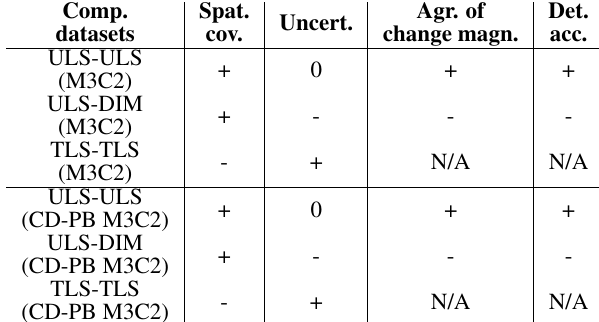
Table 3. Performance of biennial change analysis at a rock glacier with M3C2 and CD-PB M3C2 using point cloud pairs originating from UAV-borne laser scanning (ULS), UAV-borne photogrammetry using dense image matching (DIM), and terrestrial laser scanning (TLS) as input. Performance (+: best; 0: medium; -: worst of the two/three options) is evaluated with respect to spatial coverage, uncertainty of quantified change, the accuracy of change magnitudes and change detection compared to the TLS-TLS reference. ficant change in 89% – 90% of the area. Despite higher LoDe- tection values resulting from ULS-ULS and ULS-DIM change analysis compared to TLS-TLS change analysis, magnitudes of change derived for the two-year-timespan do largely not fall be- low their associated LoDetection, thereby yielding significant changes for confident change